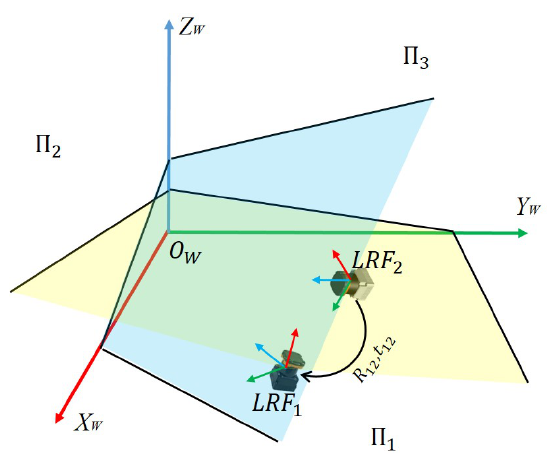
Figure 1. Calibration schematic diagram of two laser